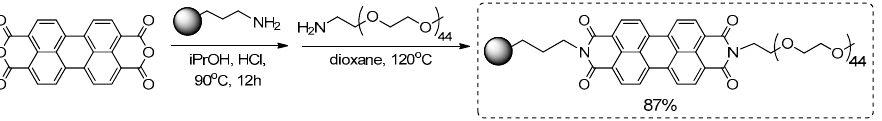
Figure 3. Reaction route for the synthesis of asymmetric pyrylene diimide.